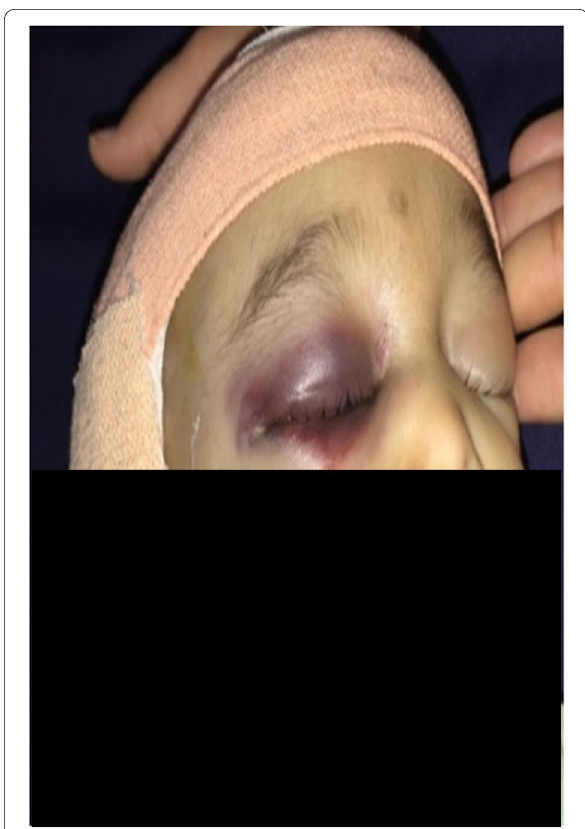
Fig. 1 Child developed unilateral periorbital ecchymosis after 36 h of surgery